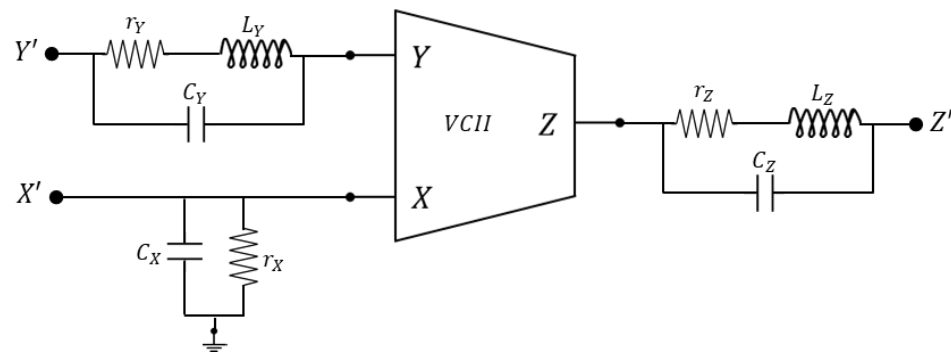
Figure 4. Real second-generation voltage conveyor.